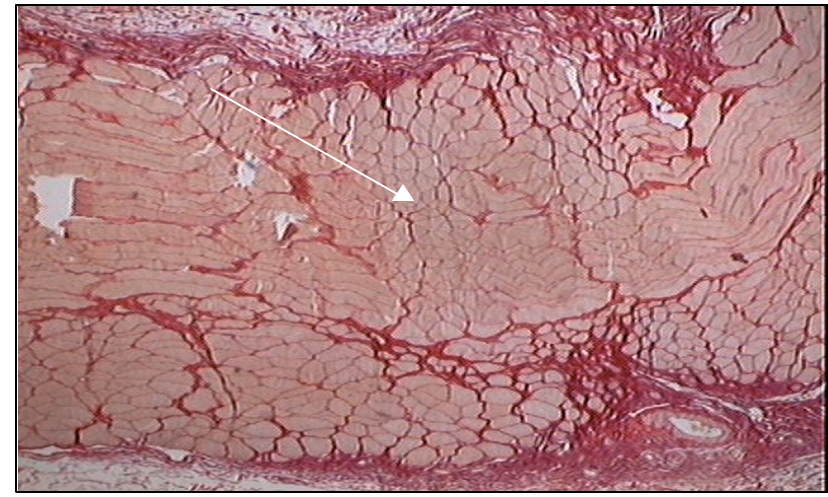
FIGURA 7 - Aspecto histológico do esôfago: sítio do enxerto, apresentando reepitelização total (seta).